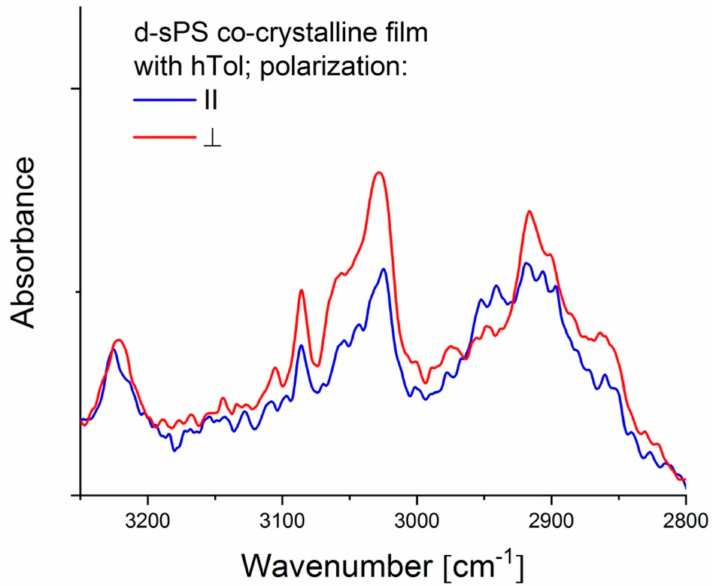
Figure 7. FTIR spectra measured with polarized IR beam parallel (blue line) and perpendicular (red line) to the uniaxially deformation direction of the d-sPS co-crystalline film with hTol: whole spectra ( top ) and detail ( bottom ) are